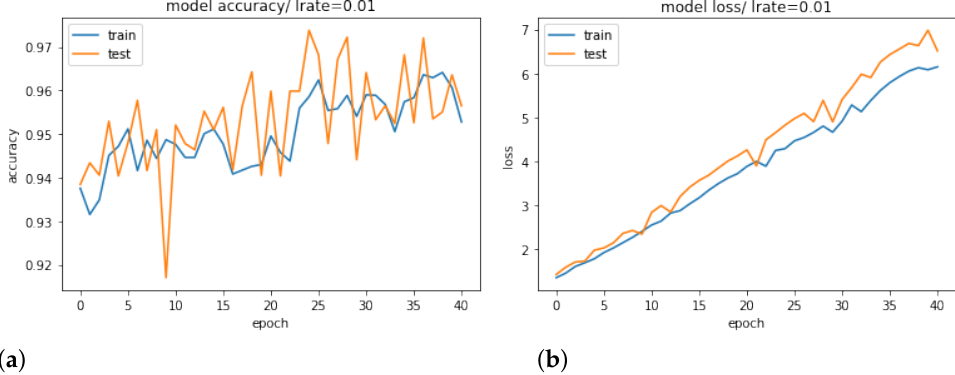
Figure 9. lr = 10 − 2 . ( a ) Train accuracy: 0.958. ( b ) Test accuracy: